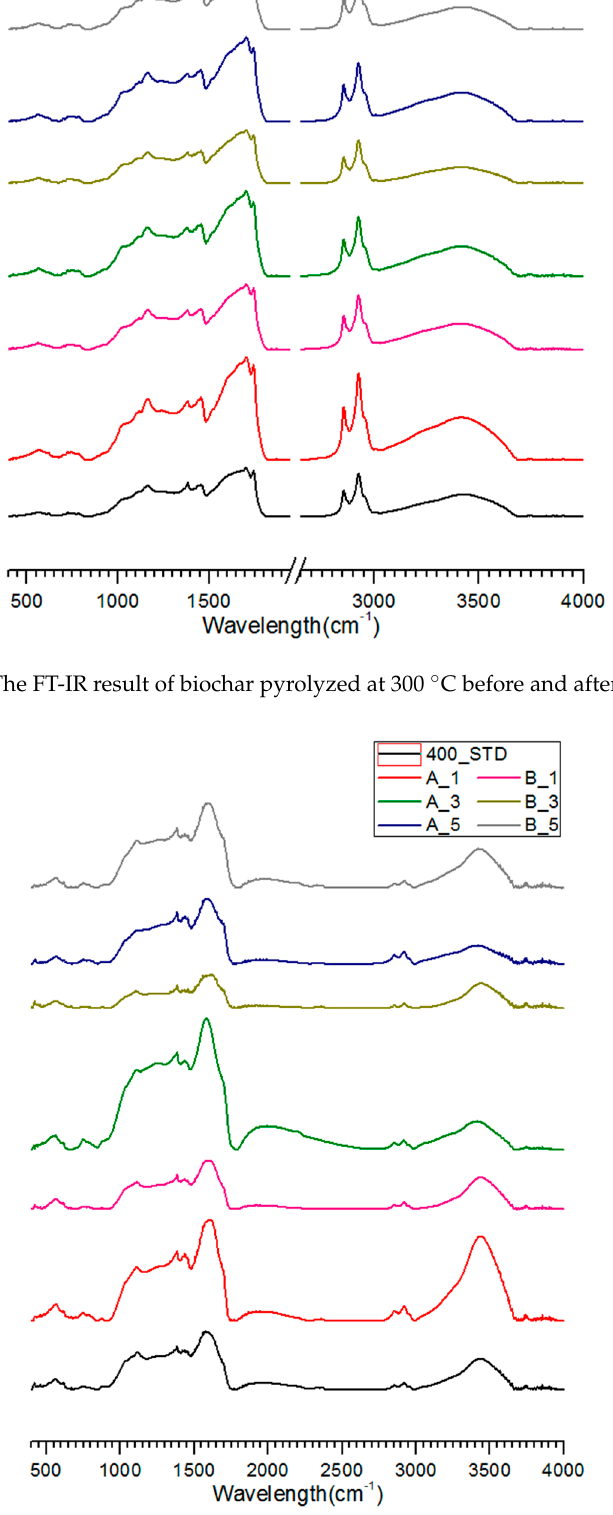
Figure 7. The FT-IR result of biochar pyrolyzed at 400 °C before and after flushing.